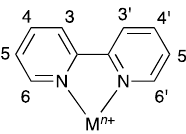
Scheme 1. Hydrogen atom numbering in 2,2 ′ -bipyridine; the conformation adopted by the metal- coordinated chelating ligand is